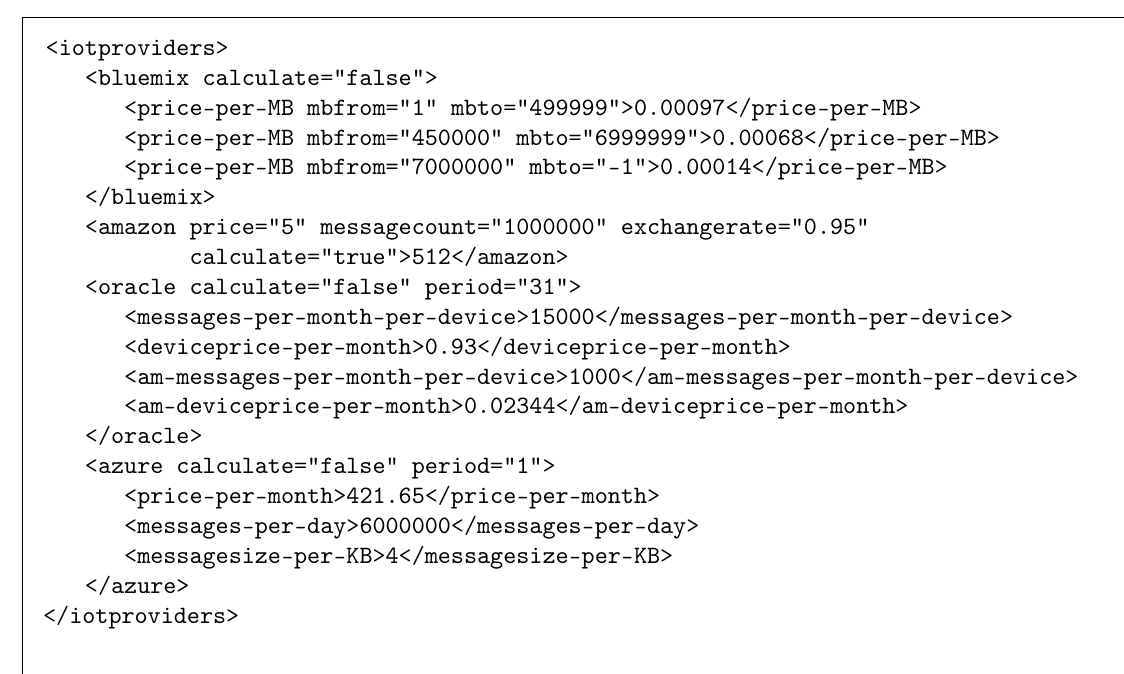
Figure 2. Cost model of IoT